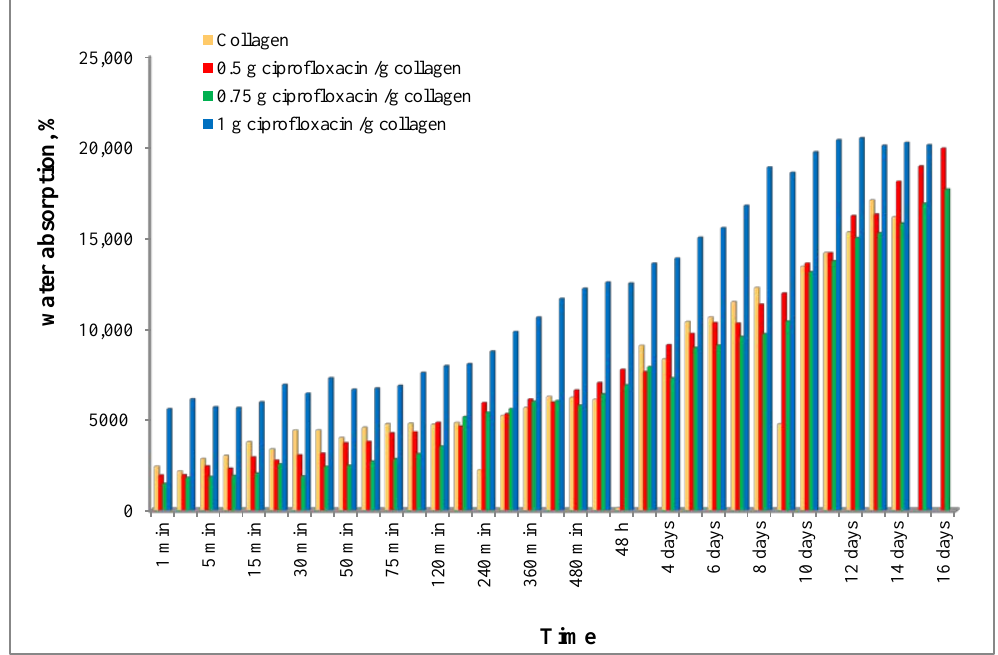
Figure 1. Water absorption behavior for the studied samples .